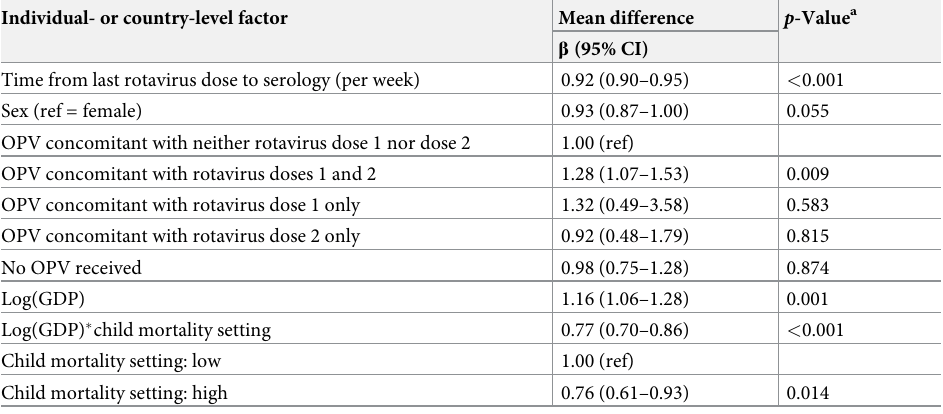
Table 7. Final serum antirotavirus IgA titer model developed using both child mortality strata combined ( n = 5,161). Individual- or country-level factor Mean